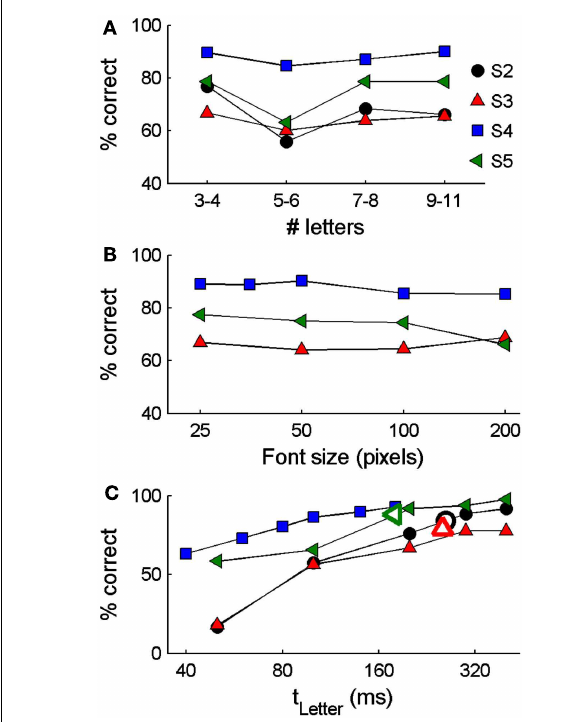
FIGURE 3 | Single word reading performance with theASP-Letters method in which the presentation rate of letters in a word is automated. Results are shown separately for words of different lengths (A) , font sizes (B) , and letter durations (C) . Subjects were tested with different conditions: in (A) , only presentation times ( t letter ) 80–200ms and font sizes of 50–100 pixels were included; in (B) , all tested word lengths (3–11 words) and letter timings of 80–200ms were included; in (C) all word lengths and font sizes of 50–100 were included. For subjects S3 and S4, the inter-letter blank duration t gap was 20ms. For subjects S2 and S5, t gap was 10ms. Open markers in (C) indicate the median letter presentation times and overall percent correct using ESP-Letters for S2, S3, and S5.